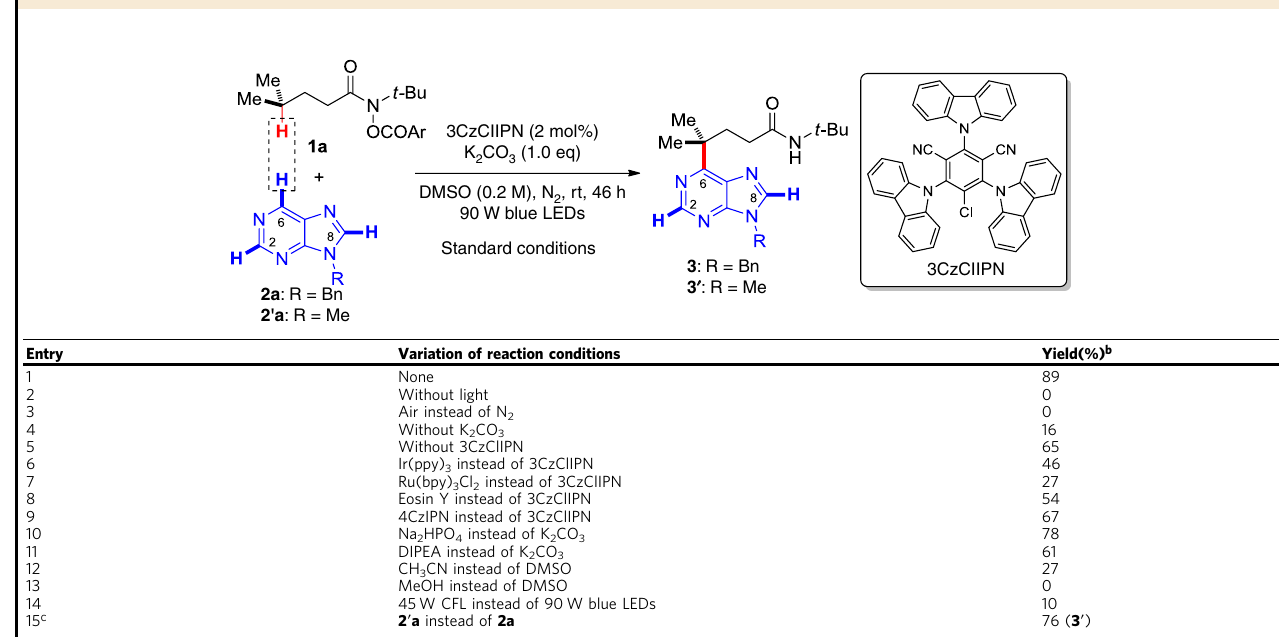
Table 1 Optimization of reaction conditions a